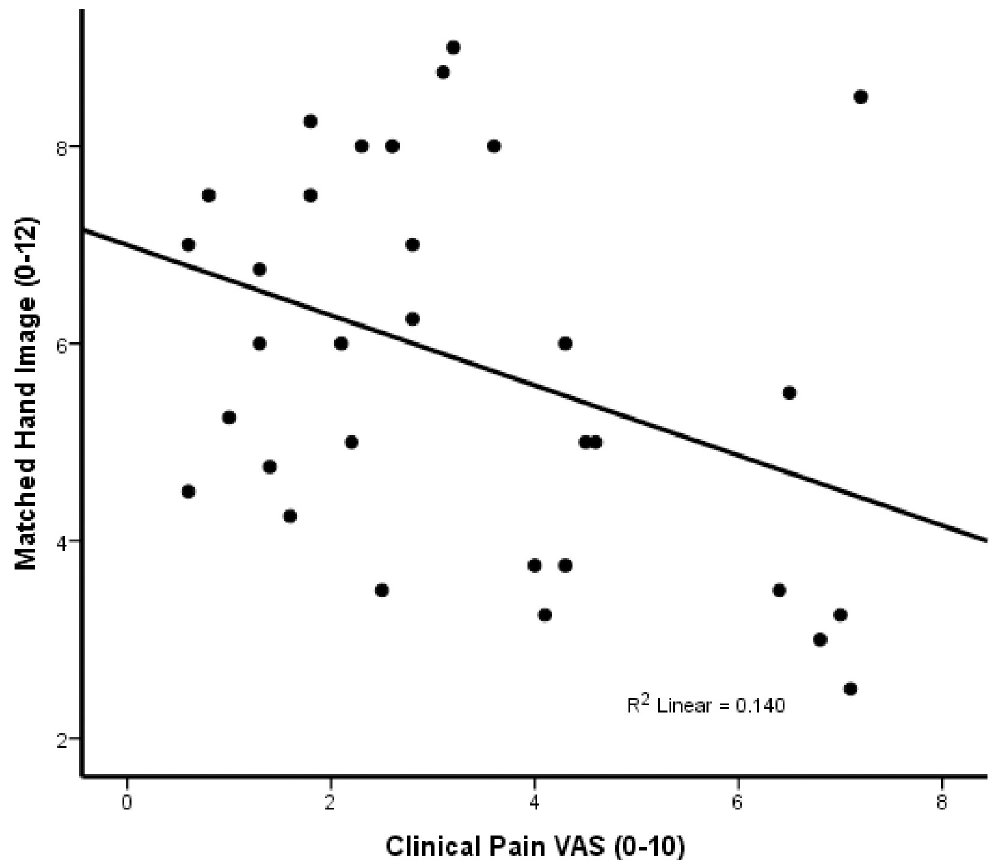
Fig 3. Pearson product moment correlations demonstrated a significant negative association between clinical pain of FM patients and their matched hand image size at baseline (p = .04). The perception of decreased hand size was associated with increased clinical FM